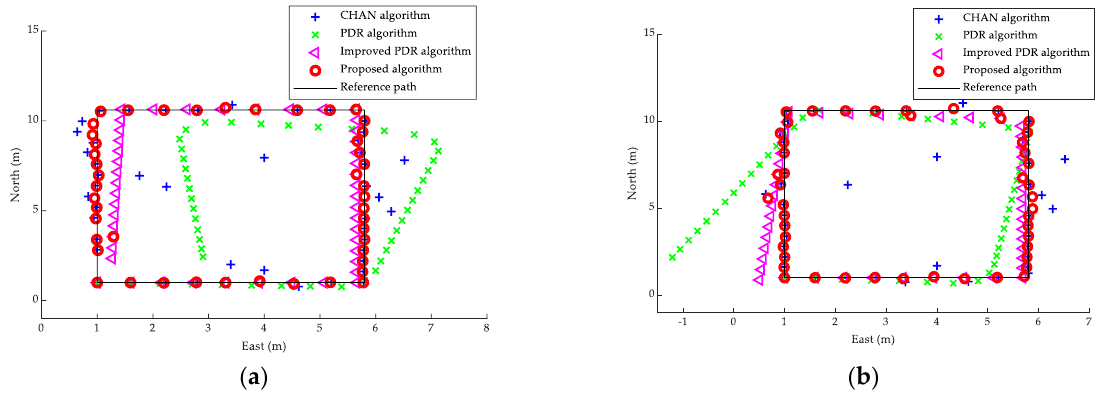
Figure 14. Localization path results among CHAN, PDR, improved PDR, and the proposed algorithm using the VivoY85a and Honor60 smartphones in the first scene. ( a ) Volunteer #2 with a VivoY85a cell phone in the first scene. ( b ) Volunteer #2 with an Honor60 cell phone in the first scene.